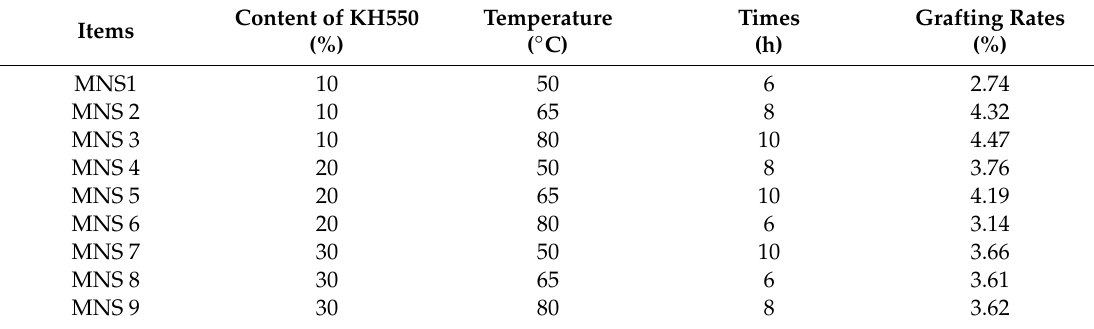
Table 3. Grafting rate of nine orthogonal experiments.